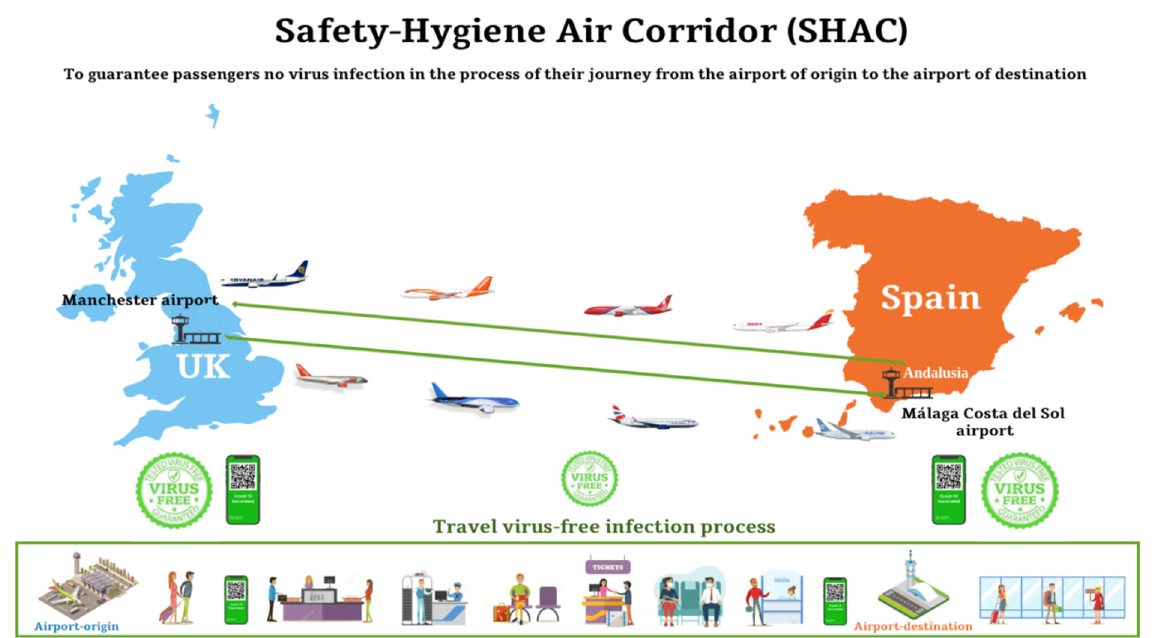
Figure 1. Safety-Hygiene Air Corridor (Travel virus-free infection process). Source. Own elabora- tion.